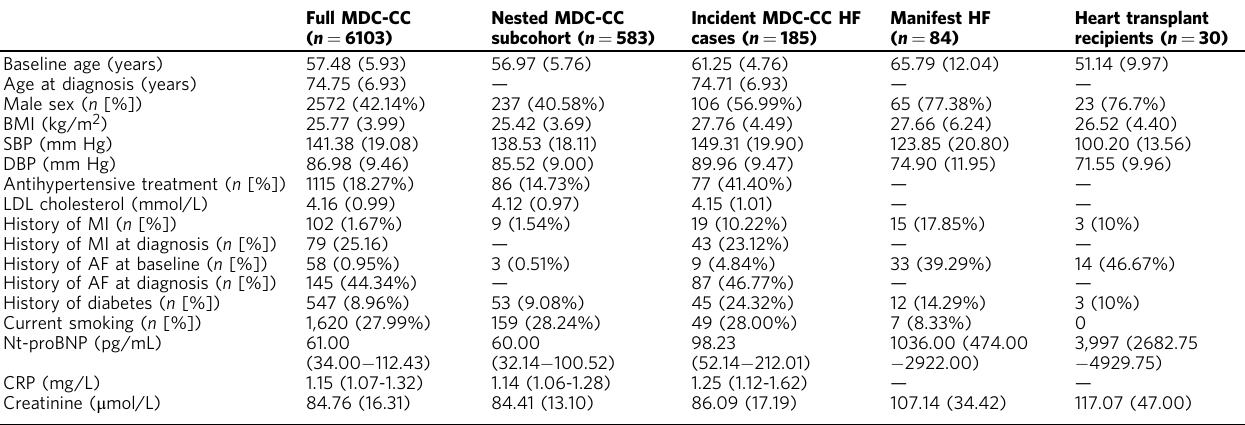
Table 1 Baseline